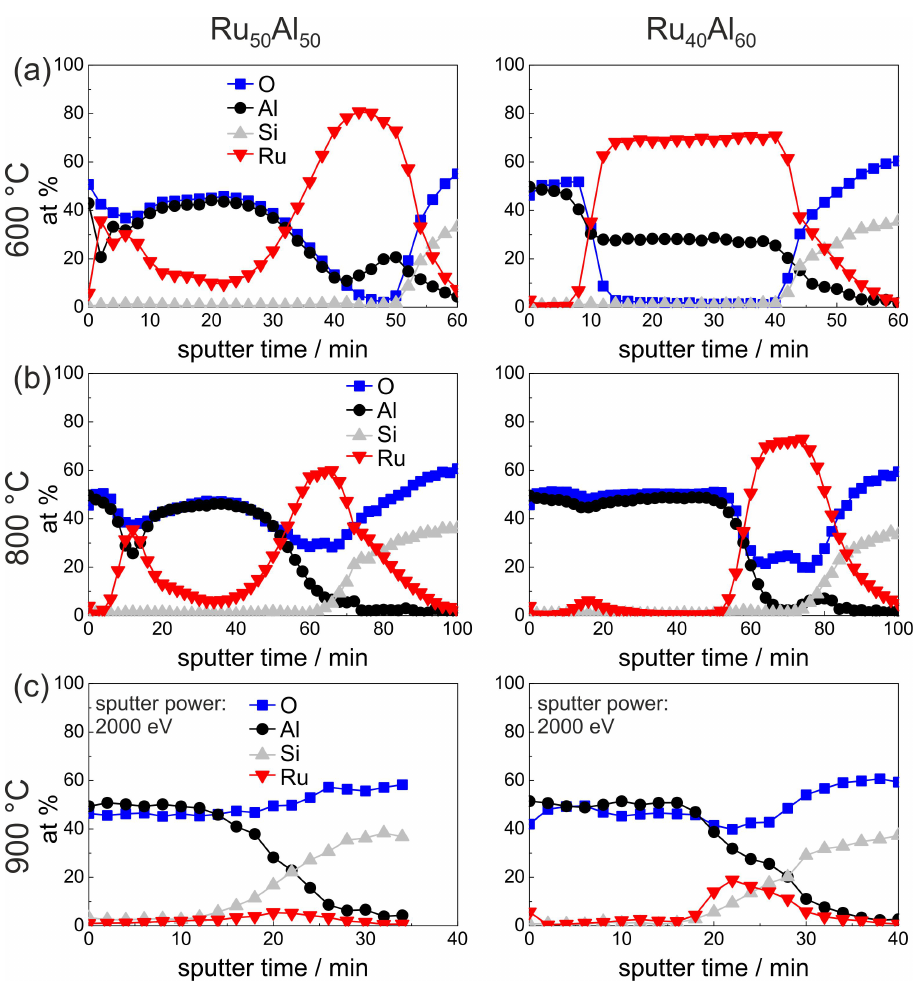
Figure 6. AES measurements of the Ru 50 Al 50 and Ru 40 Al 60 samples after annealing for 10 h in air at ( a ) 600 ◦ C; ( b ) 800 ◦ C; and ( c ) 900 ◦